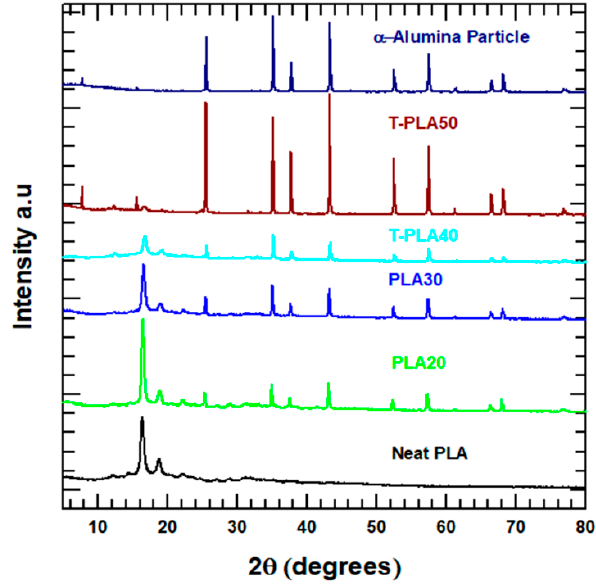
Figure 6. XRD patterns of the alumina and the PLA composites.